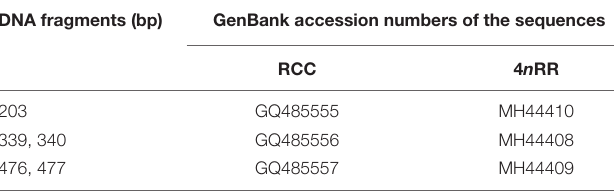
TABLE 1 | GenBank accession numbers of the 5S rDNA sequences in RCC and 4 n